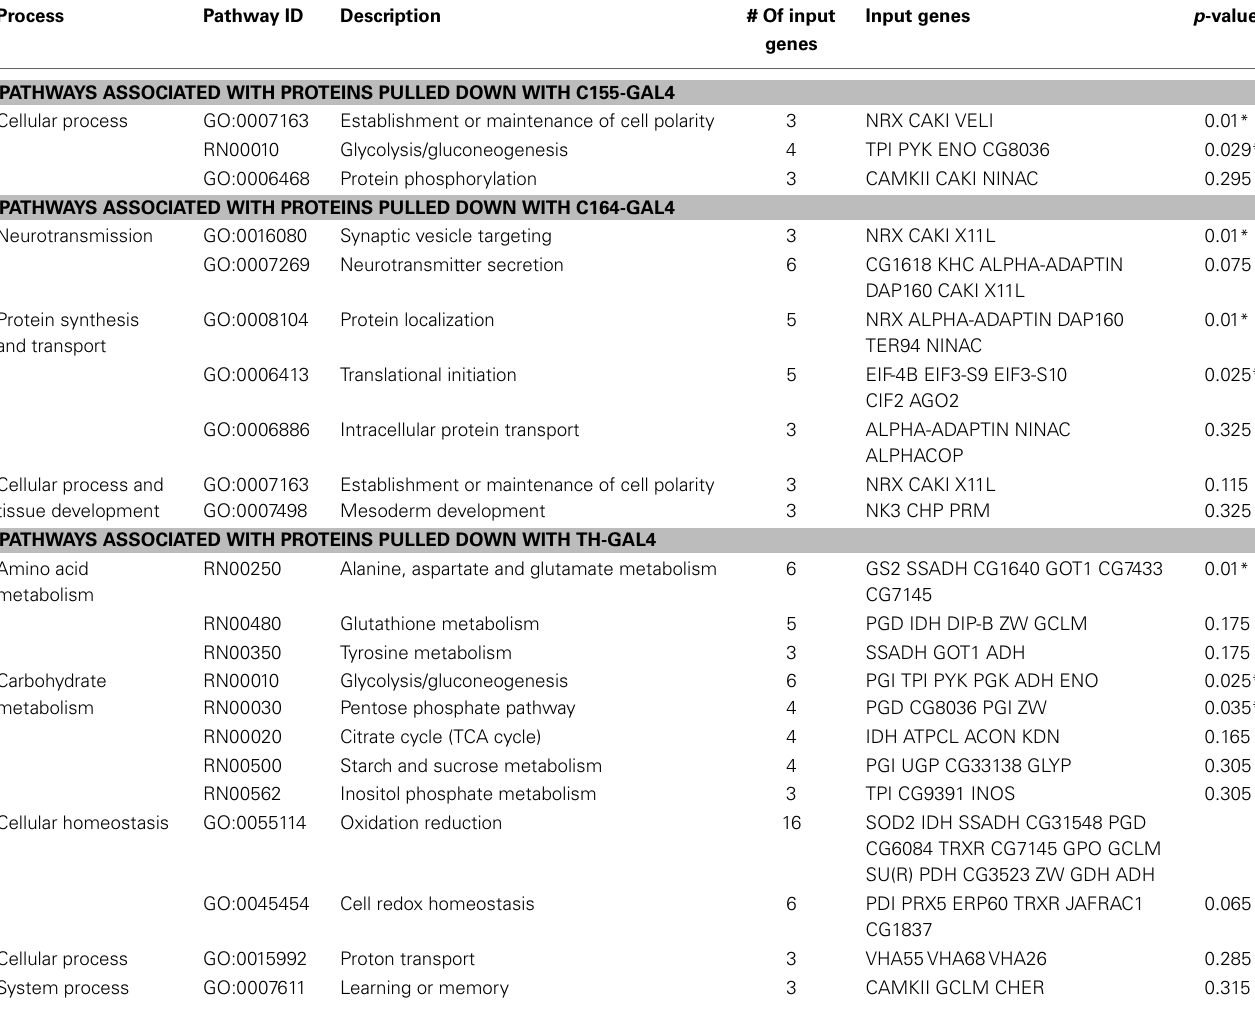
Table 1 | Pathway analysis of associated